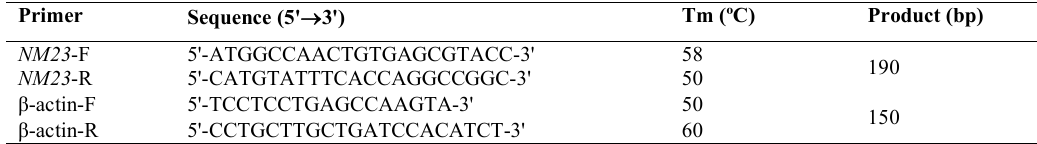
Table 1: The sequences of primers were used in this study.